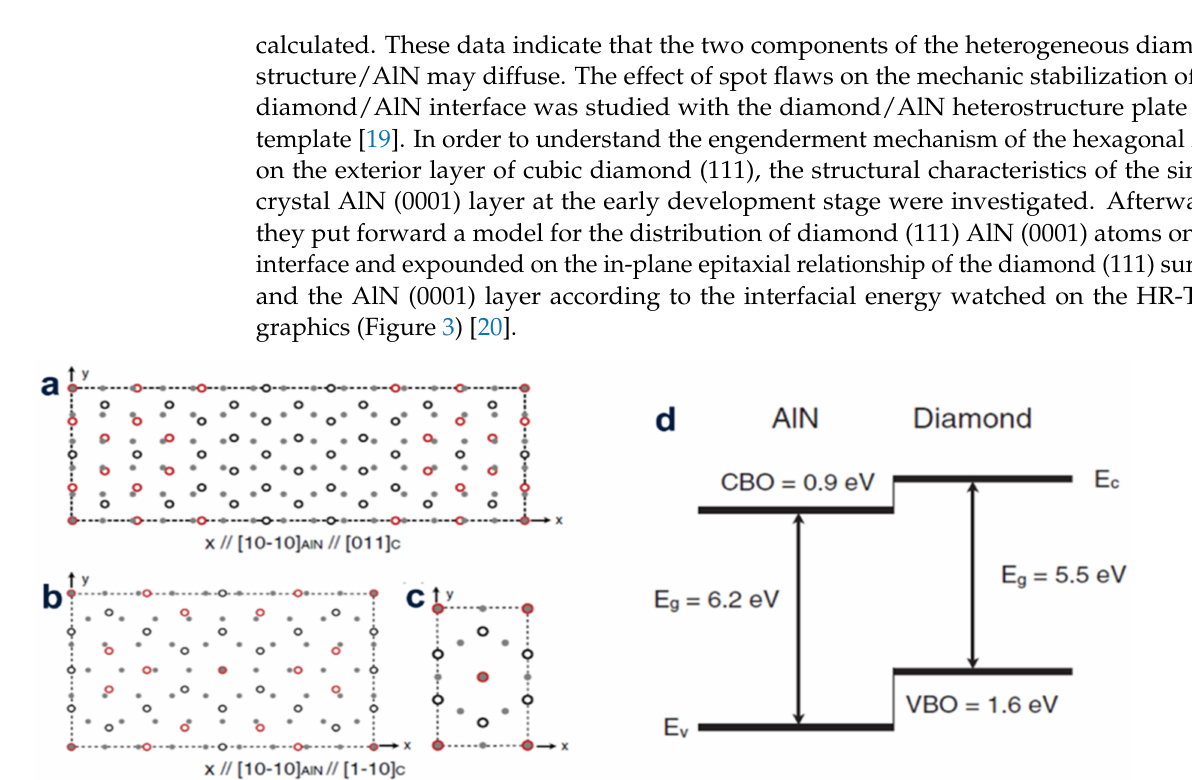
Figure 2. The vertical view of the supercell imitating the heterojunctions H 1 and H 2 ( a ), H 3 ( b ) and H 4 ( c ). A gray disk shows the deputy the carbon atomic layers nearest to the interface and a hollow circle shows the deputy the nitrogen atomic nearest to the interface. Red hollow circles express N atoms bonded to C and black hollow circles express N atoms with dan-gling bonds. Dotted wires represent cells in the flat surface. ( d ) Computed band alignment. The experimental band gaps ( E g ) gave date of the average valence-band offset (VBO) and the corresponding conduction-band gaps (CBO) are shown.